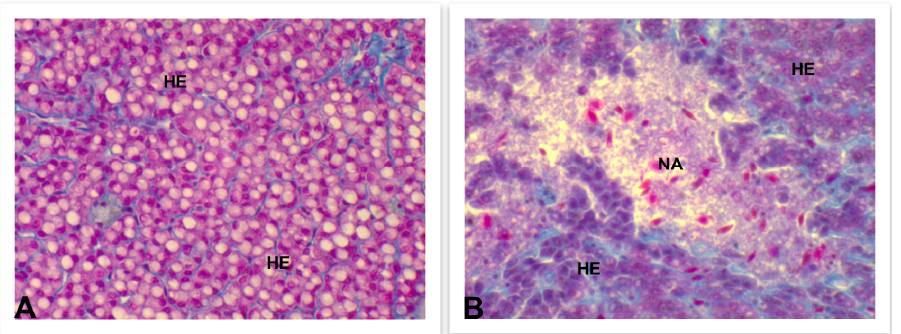
Figure 5. Light micrographs of the liver of Anguilla anguilla . Mallory staining. ( A ) Control and ( B ) exposed specimens. In exposed specimens, the hepatocytes (HE) were devoid of lipids; necrotic areas (NA) and loss of parenchymal cells were evident. Magnification: 400×. and a posterior mesonephric kidney, with excretory and endocrine functions, where most